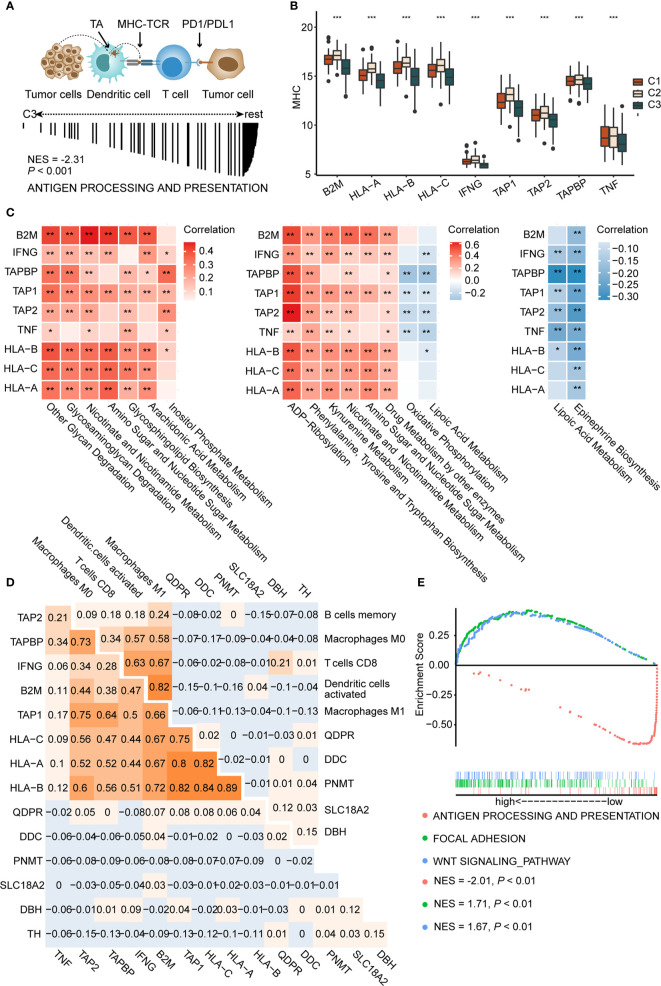
Activation of epinephrine biosynthesis correlates inversely with expression of MHC molecules and antigen presentation (A) Schematic diagram of antigen presentation. First, tumor antigens released by tumor cells are captured by dendritic cells. Next, dendritic cells present the captured antigens on MHC-I molecules to T cells, leading to activation of T cells. Activated T cells infiltrate the tumor bed and kill tumor cells. TA, tumor antigen (A, up). GSEA plot showing the negative enrichment of antigen processing and presentation in C3 compared to C1 and C2 (A, down). (B) The boxplot of MHC molecules in three subtypes. P values are the results of Kruskal-Wallis test for three subtypes. (C) Correlation matrix of characteristic metabolic pathways of each subtype and expression of MHC-I molecules (left, C1, middle, C2, right, C3.) Correlation coefficients are represented in the form of heatmap using colored scale ranging from blue (minimum correlation) to red (maximum correlation). (D) Correlations between genes in epinephrine biosynthesis pathway and MHC-I molecules (D, left) and antigen presentation cells (D, right) were determined by Spearman correlation analysis. The numbers are the correlation coefficient. (E) Grouping the patients in the TCGA cohort according to the median expression of TH. GSEA plot showing the negative enrichment of antigen processing and presentation in the high TH expression group compared with low TH expression group. (*P < 0.05; ** P < 0.01; ***P < 0.001).